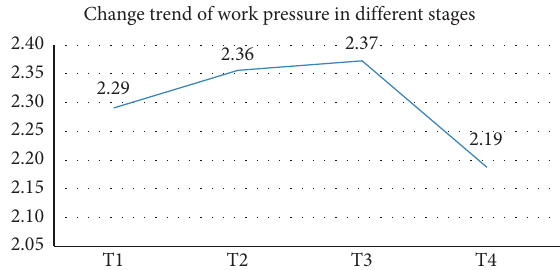
Figure 2: Trends of job stress of the survey respondents in diferent stages.